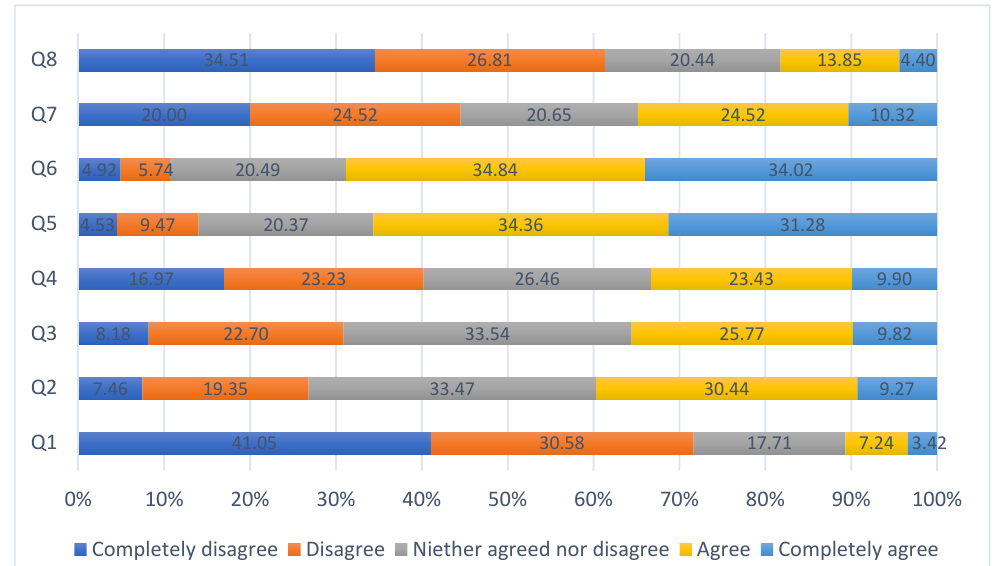
Figure 4. The PV users’ opinions regarding PT service on a 1–5 Likert scale.